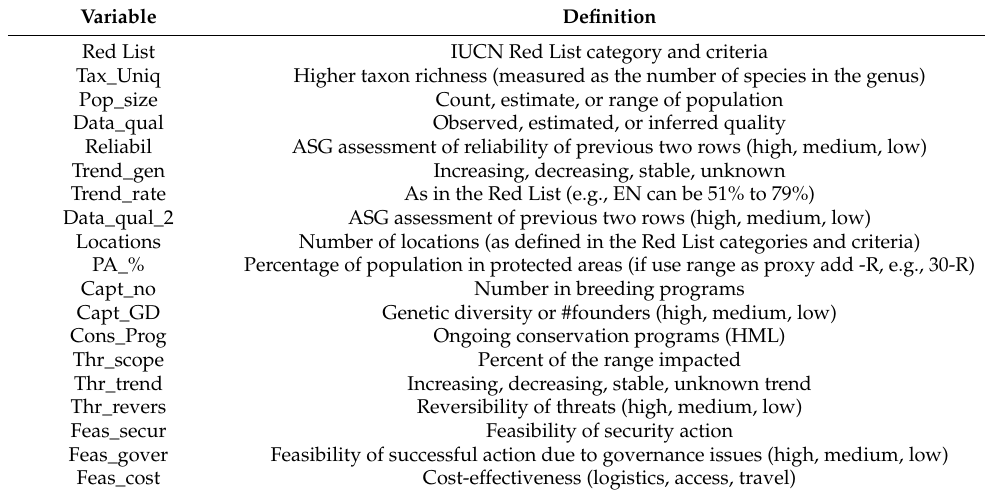
Table 1. ASG variable list and definitions.